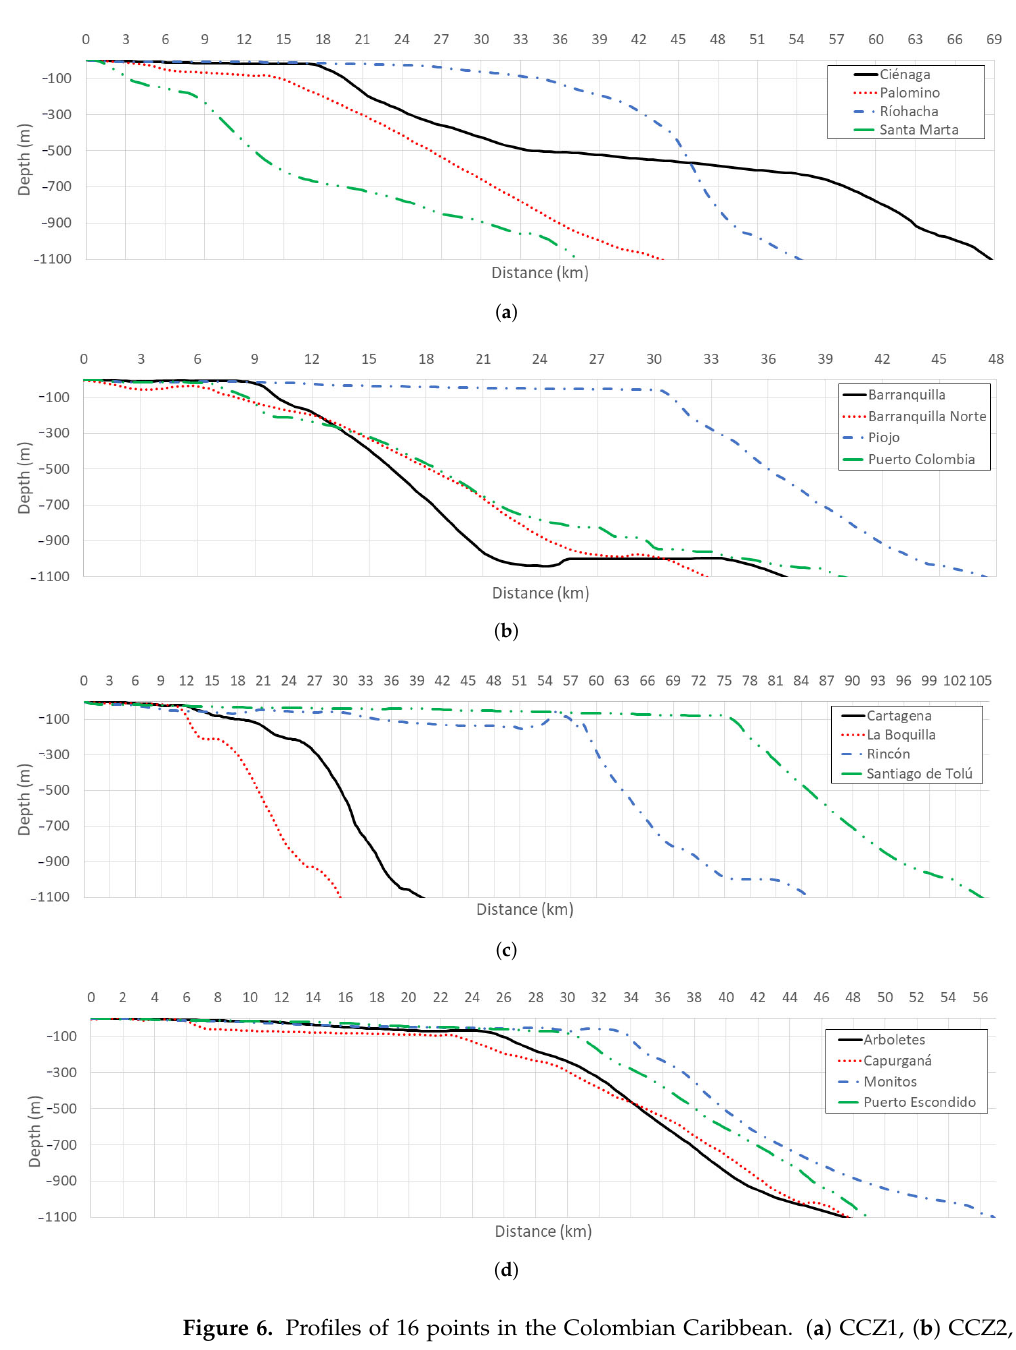
Figure 6. Profiles of 16 points in the Colombian Caribbean. ( a ) CCZ1, ( b ) CCZ2, ( c ) CCZ3, and ( d )